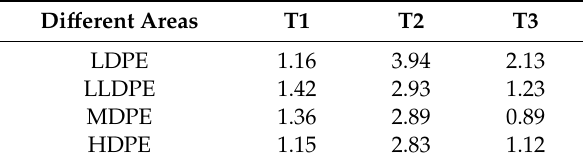
Figure 7. Logarithmic form fitting diagram of electrical conductivity flow of four di ff erent density polyethylenes. The logarithmic form of the conductance characteristic curve of ( a ) LDPE, ( b ) LLDPE, ( c ) MDPE, ( d ) HDPE. Table 3. The slope of the line in di ff erent areas of di ff erent materials.